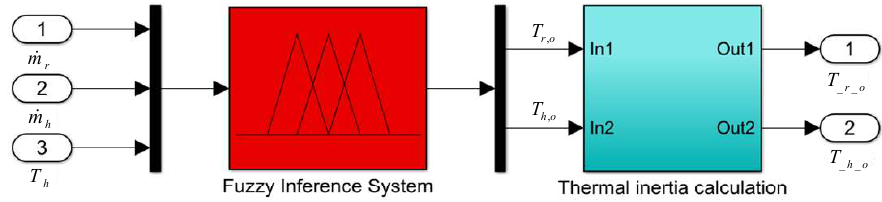
Figure 9. Fuzzy-based dynamic evaporator model.